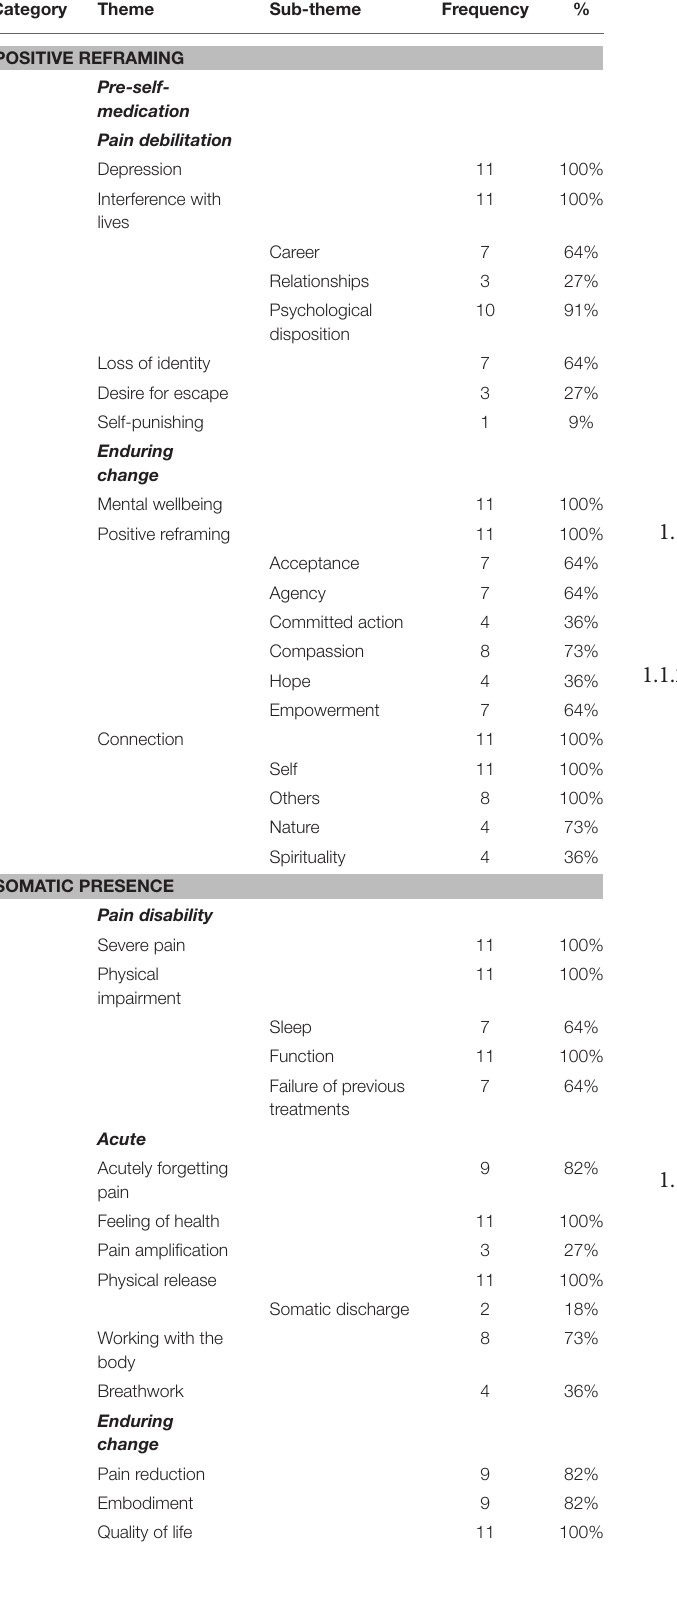
TABLE 3 | Summary of categories, themes, sub-themes, and frequencies. Category